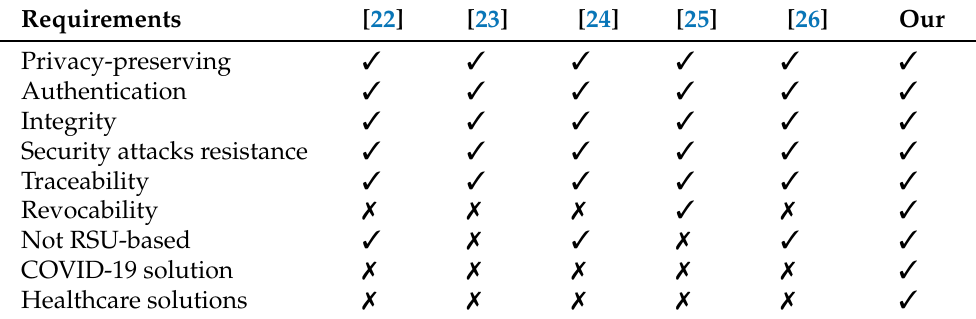
Table 1. Comparison of Privacy and Security